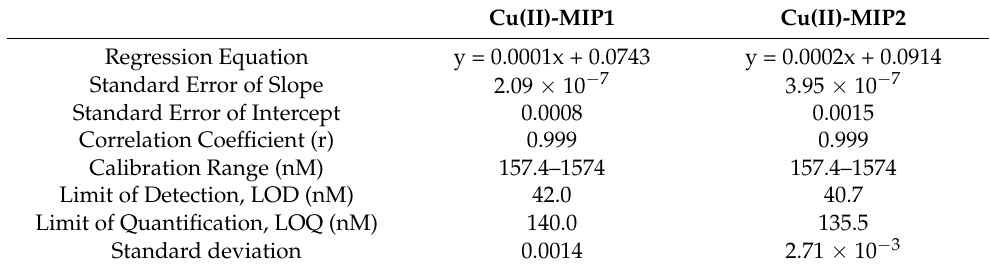
Table 4. Calibration function properties of Cu(II)-MIP1 and Cu(II)-MIP2 QCM nanosensor analysis.